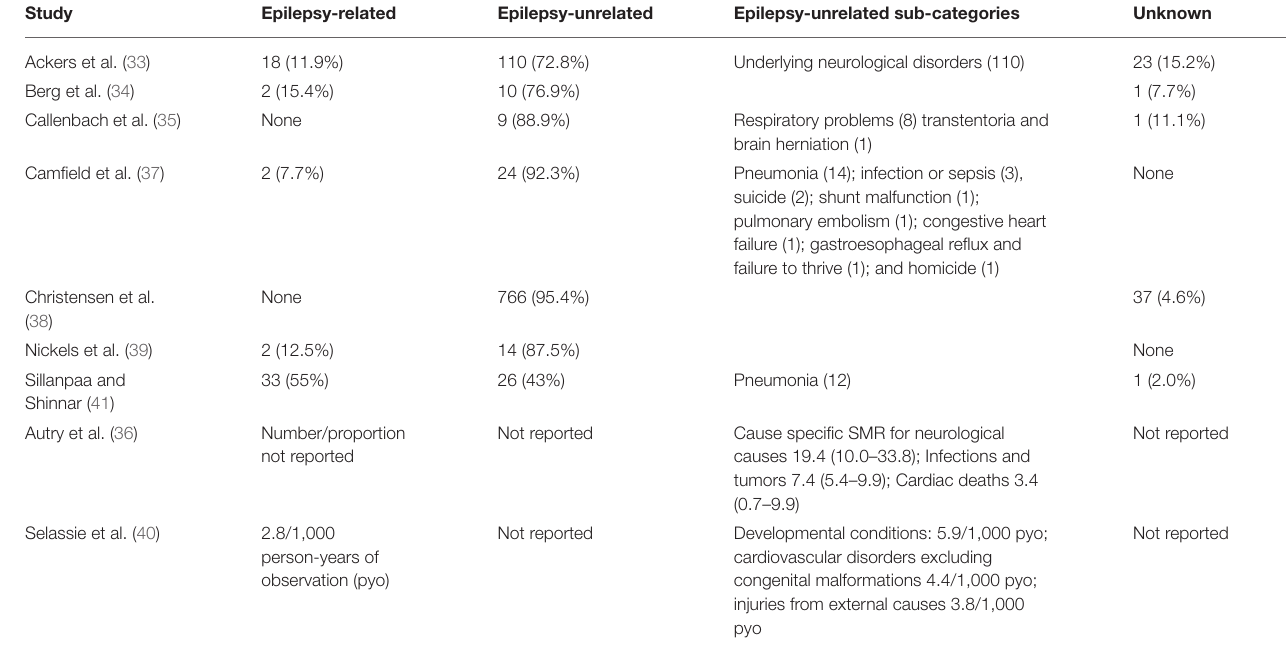
TABLE 3 | Proportionate mortality or cause-specific mortality rates/ratios for epilepsy and non-epilepsy related